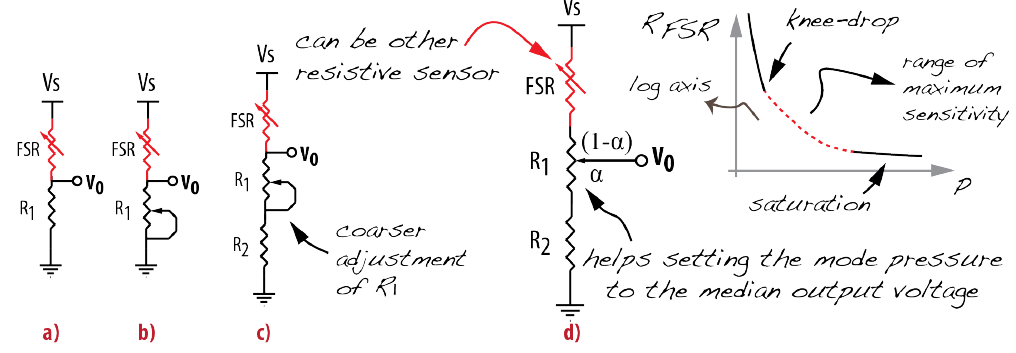
Figure 7. Voltage divider topologies. ( a ) simplest solution; ( b ) output offset adjustment; ( c ) safety improvement; ( d ) safety and finer